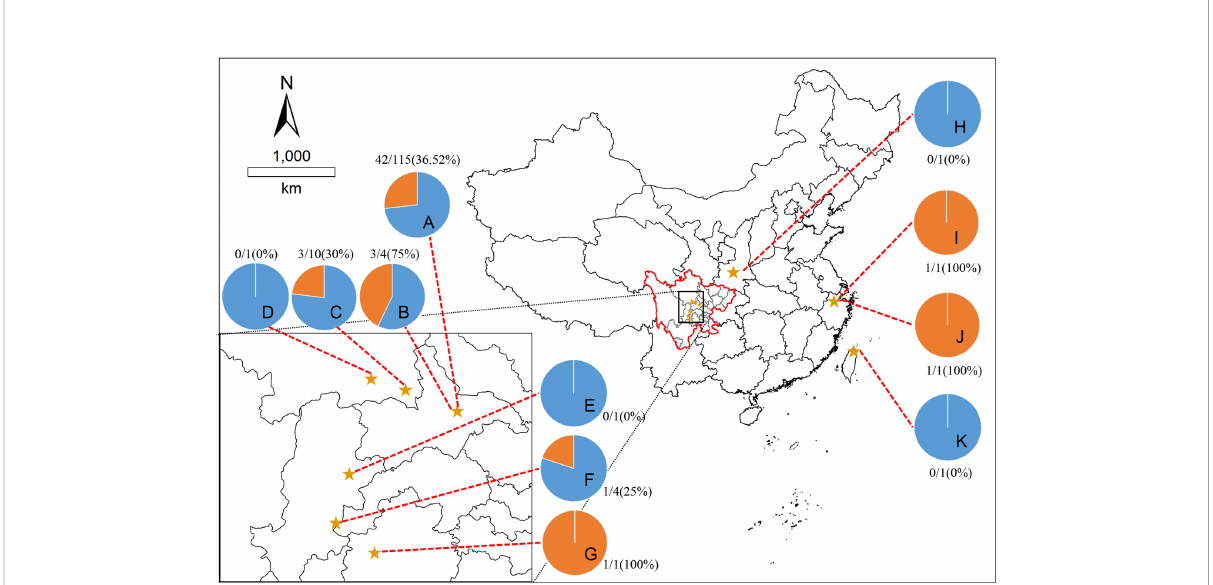
FIGURE 1 Map showing eleven sampling sites. The pie charts showed the seroprevalence of giant pandas for T. gondii in different sampling sites, the blue part is negative, and the orange part is positive. The locations represented by the letters: (A) , Chengdu Research Base of Giant Panda Breeding, Chengdu, Sichuan; (B) , Chengdu Zoo, Chengdu, Sichuan; (C) , Chengdu Field Research Center for Giant Panda-Panda Valley; (D) , China Conservation Research Center for Giant Panda, Wolong, Sichuan; (E) , China Conservation Research Center for Giant Panda, Yaan, Sichuan; (F) , Sichuan Daxiangling Research Base of Giant Panda Reintroduction, Sichuan; (G) , Heizhugou National Nature Reserve, Leshan, Sichuan; (H) , Shanxi Rare Wildlife Research Center Zhouzhi, Shaanxi; (I) , Hangzhou Zoo, Hangzhou, Zhejiang; (J) , Anji Bamboo Expo Park, Anji, Zhejiang; (K) , Taibei Zoo, Taibei,